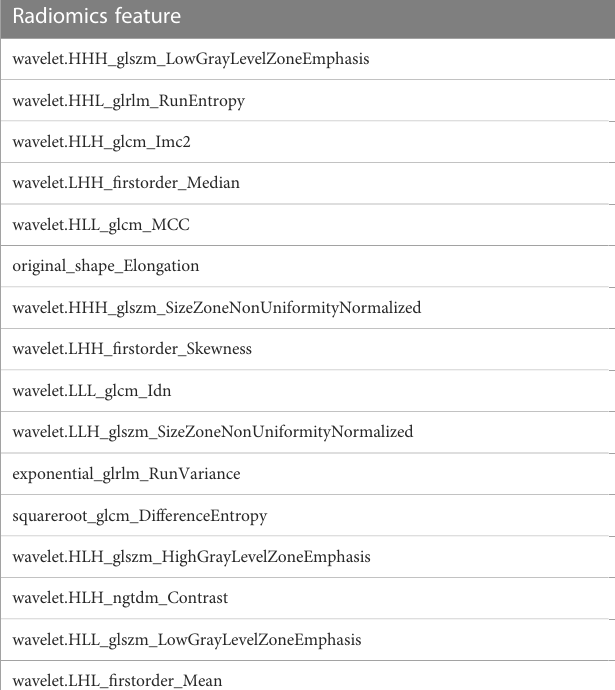
TABLE 5 Radiomics features used to construct RCR features obtained after lasso selecting. Radiomics